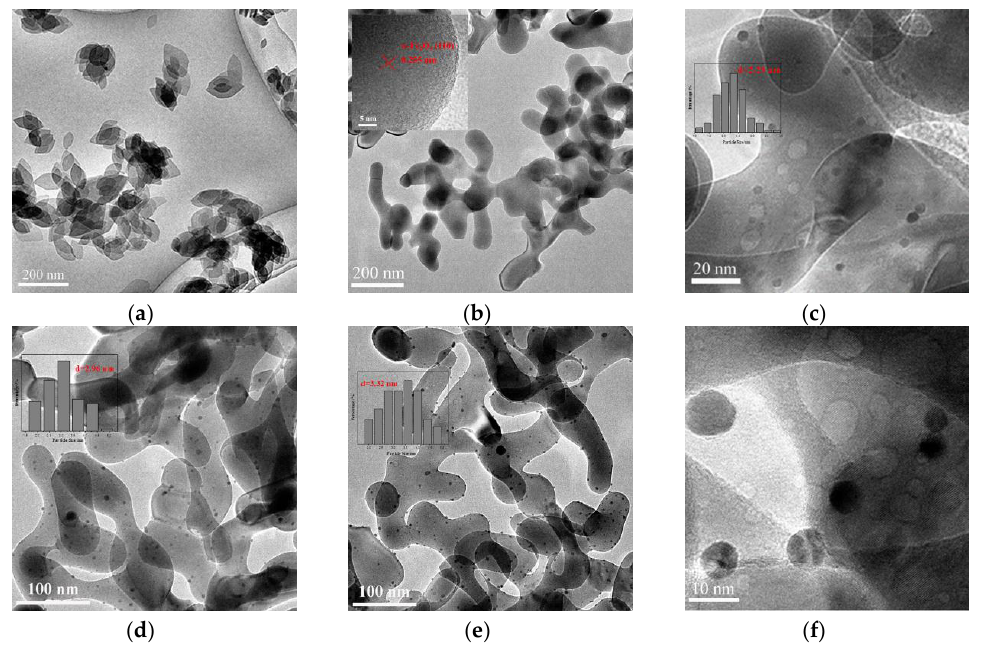
Figure 3. Transmission electron microscopy (TEM) images of ( a ) precursor; ( b ) α-Fe 2 O 3 ; ( c ) 1.86%, ( d ) 2.72% and ( e ) 3.59% Au/α-Fe 2 O 3 catalysts calcined at 300 °C; ( f ) 1.86% Au/α-Fe 2 O 3 catalysts calcined at 500 °C.